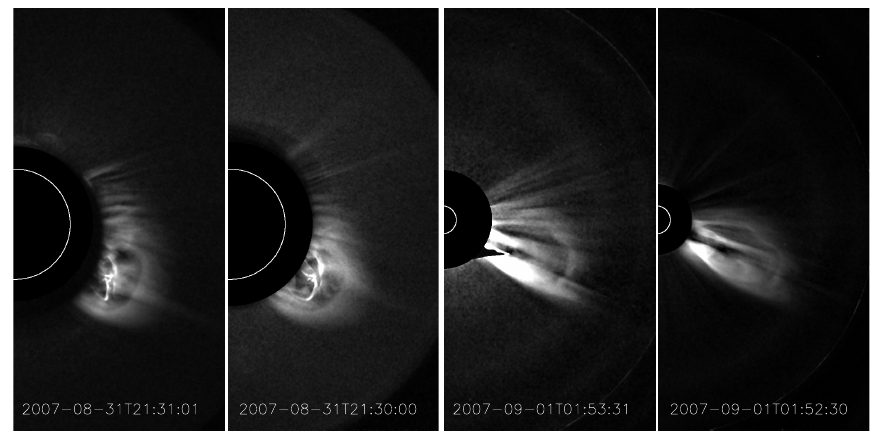
Fig. 1. The CME on 31 August–1 September 2007 observed by SECCHI-COR1 (the left two columns) and by SECCHI-COR2 (the right two columns) coronagraphs. Both A (second and fourth columns) and B (first and third columns) spacecraft images are shown. COR1 images show the white light total brightness corona from 1.4 to 4 R (cid:12) . COR2 images show the white light total brightness corona from 2.5 to 15 R (cid:12) . In all panels the visible solar disc is represented by the white circle, while the larger dark disc shows the coronagraph occulter. The images were co-aligned in the STEREO mission plane. Adapted from Mierla et al.